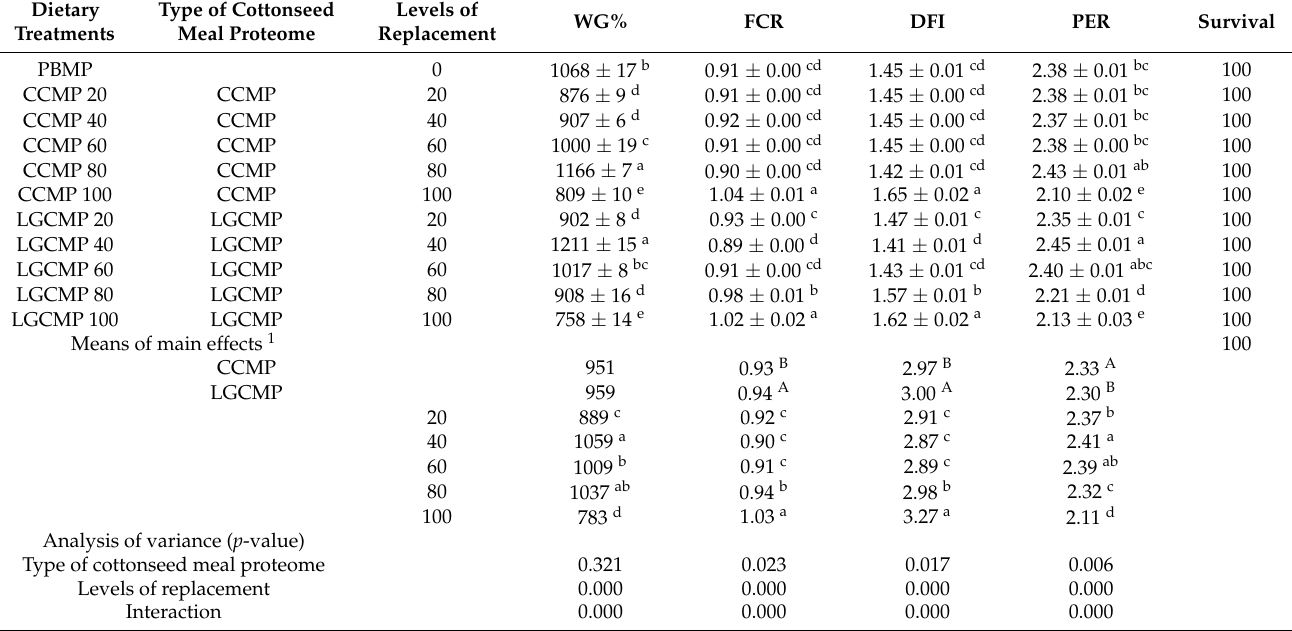
Table 3. Growth performance and feed utilization of hybrid grouper juveniles fed different experi- mental diets for 9